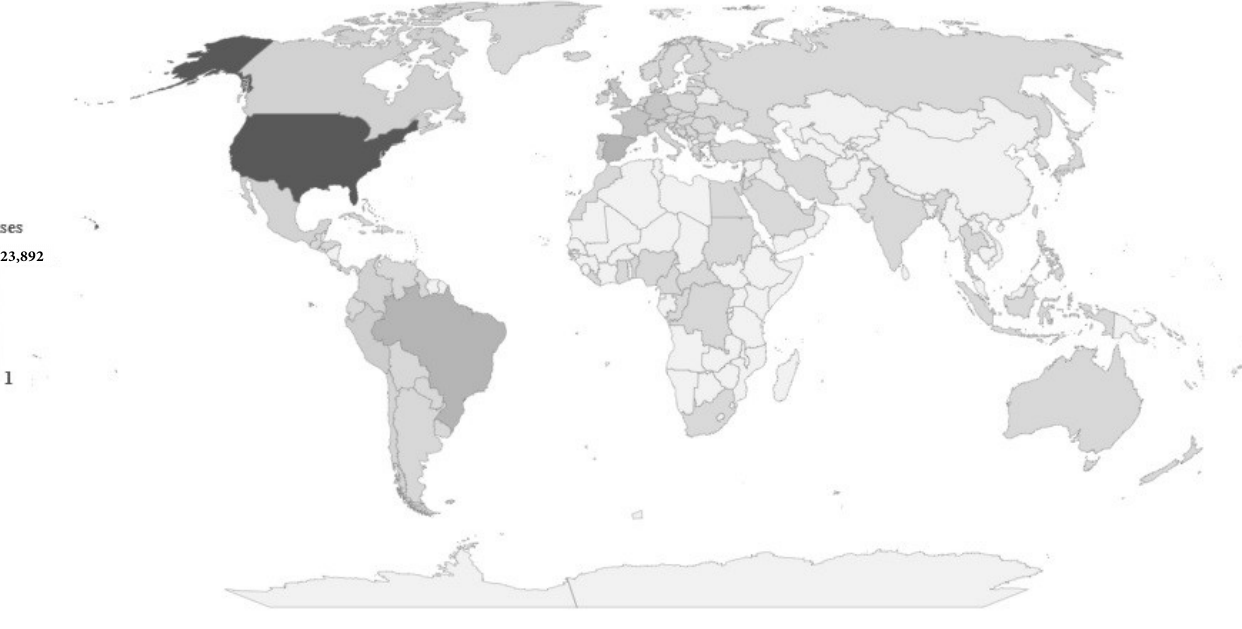
Figure 1. 2022 Human monkeypox outbreak global map: Cumulative number of confirmed cases, by countries, data as of 19 September 2022. (Source of data: reference